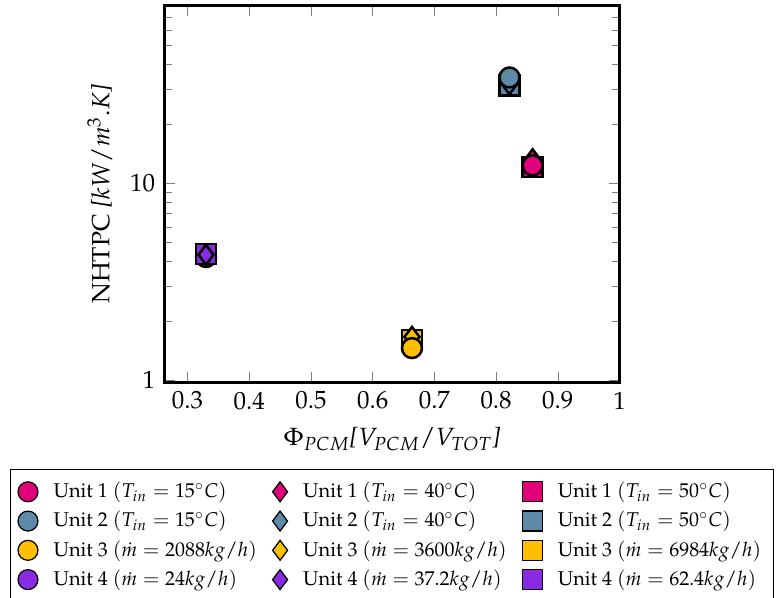
Figure 1. Sensitivity analysis. Calculated NHTPC vs. Φ PCM at different temperature levels and HTF mass flow rates in logarithmic